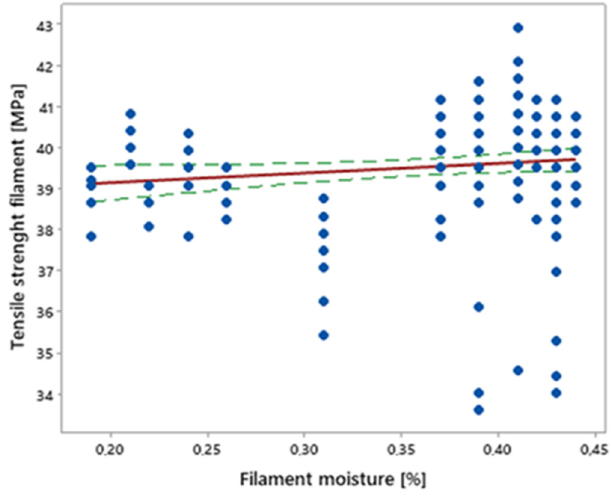
Figure 7. Influence of filament moisture on its tensile strength (red—regression line, green—confidence interval; confidence level = 0.95.